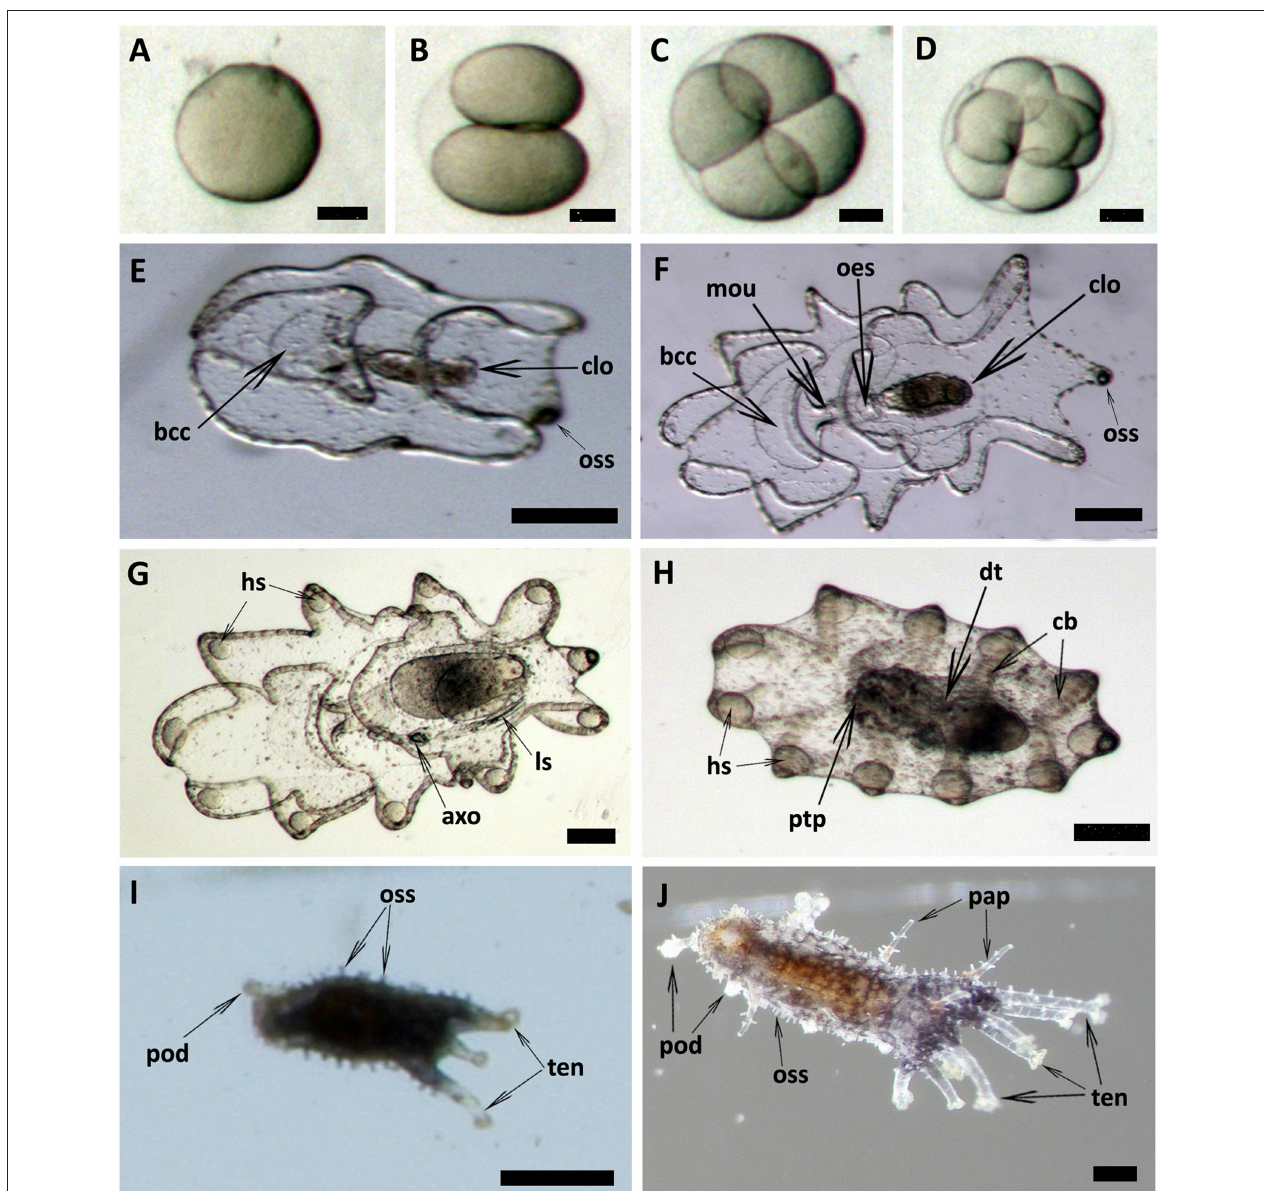
FIGURE 7 | Embryonic, larval development and juvenile growth of Holothuria scabra from RGP-matured eggs. (A) the matured eggs were fertilized, then (B–D) 2-cell, 4-cell and multi-cell division was occurred until 8h post-fertilization. (E) early auricularia stage at 2 days post-fertilization (dpf). Buccal ciliated cavity (bcc), cloaca (clo), ossicle (oss). (F) Mid-auricularia stage at 5 dpf. Mouth (mou), oesophagus (oes). (G) Late-auricularia at 14 dpf. Hyaline sphere (hs), axohydrocoel (axo), left somatocoel (ls). (H) Doliolaria at 16-day; digestive tract (dt), ciliary band (cb), primary tentacles primordium (ptp). (I) Pentactula at 21 dpf. Tentacle (ten), podia (pod). (J) Juvenile at 36 dpf. Papillae (pap). Scale bars in (A–D) are 50 µ m. Scale bars in (E–H) are 100 µ m. Scale bars in (I,J) are 500 µ